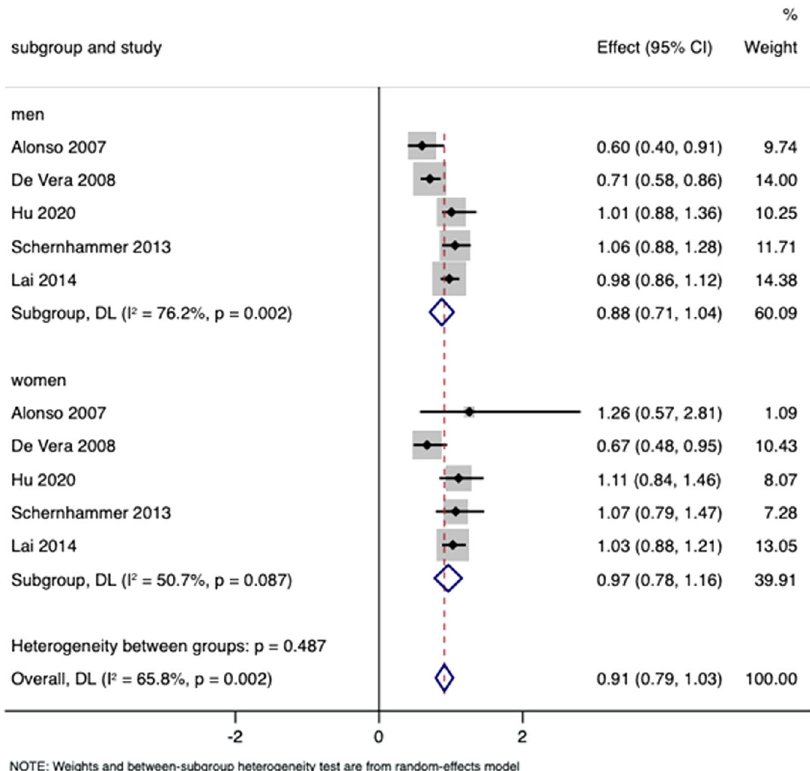
Fig. 8 Subgroup analyses by sex on the association between gout and PD risk. RRs were 0.97 (95% CI 0.78 – 1.16) in females and 0.88 (95% CI 0.71 – 1.04) in